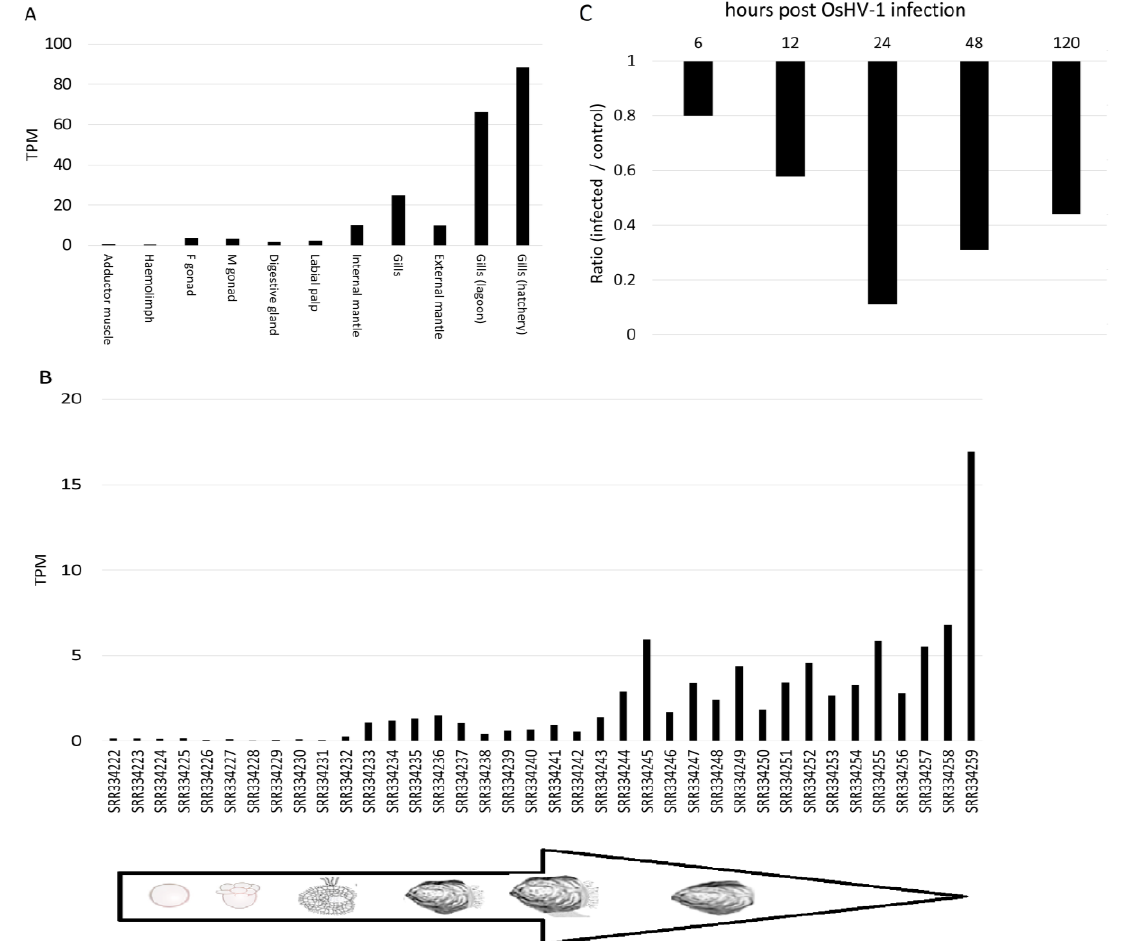
Figure 6. Expression levels of the C. gigas DCE / yellow . The expression values are reported as TPM. ( A ) Different oyster tissues [42], including the two gill RNA-seq samples described in this work; ( B ) during ontogeny [42]; ( C ) along a 0–120 hours’ time-course OsHv-1 infection experiment [59], in this case reported as fold change of treated versus control samples.